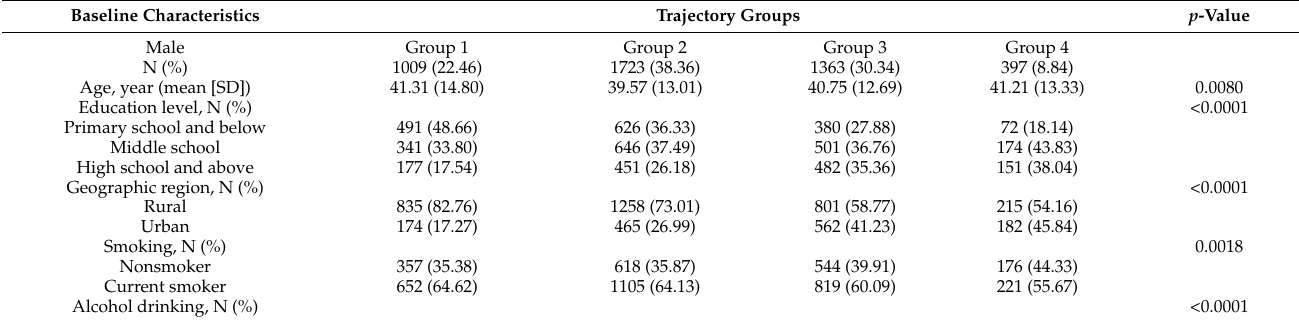
Table 1. Baseline characteristics of the study